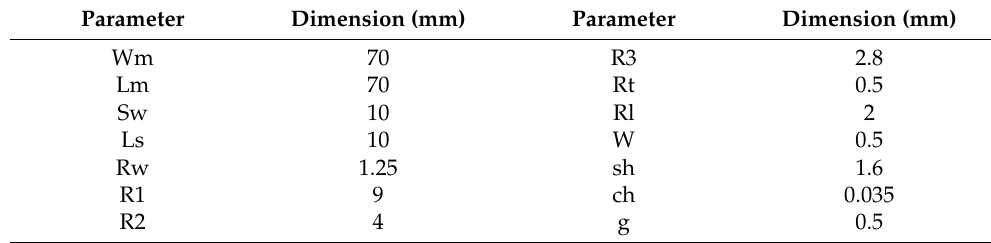
Table 1. Dimensional parameters of the 7 × 7